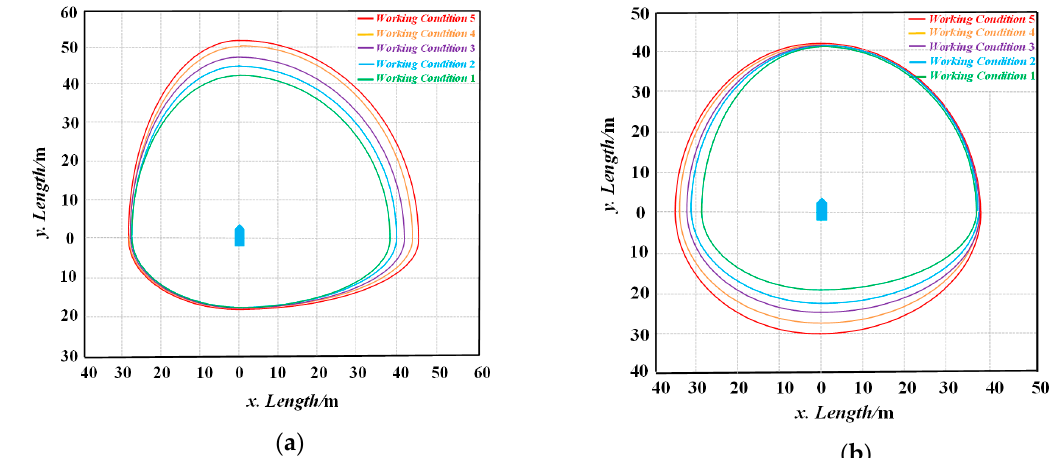
Figure 11. Radius changes of the DNSD in the crossing situation: ( a ) Under the first angle groups; ( b ) Under the second angle groups.